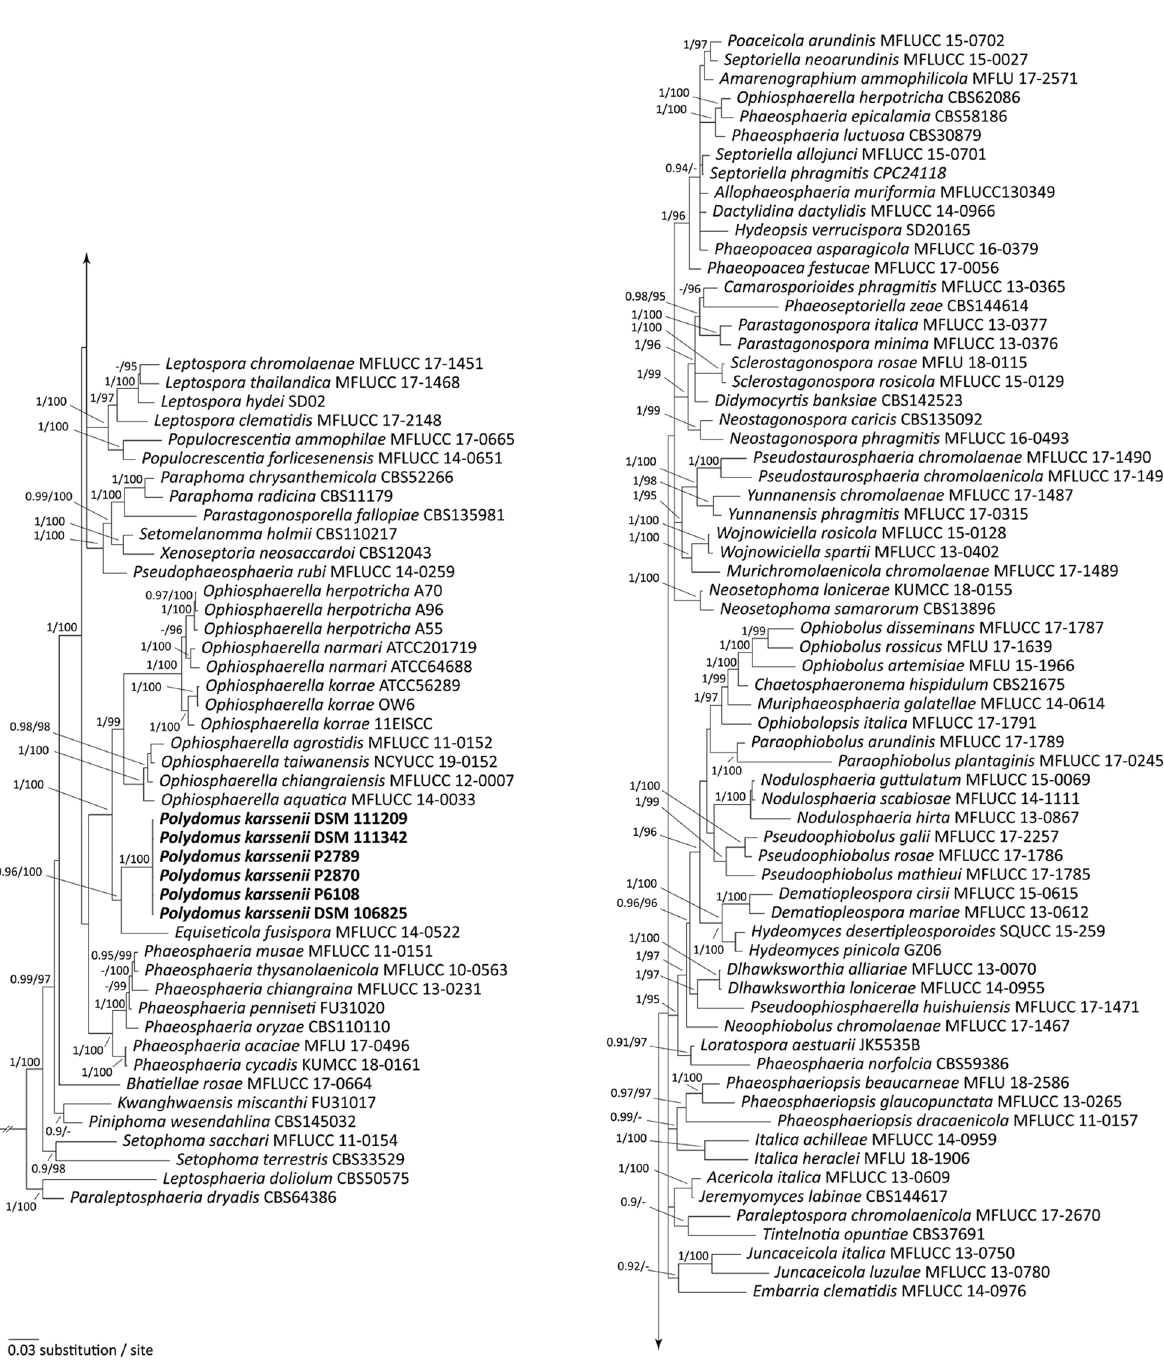
Fig. 3 Bayesian inference of the phylogenetic relationship of the fungus described here among Phaeosphaeriaceae based on ITS, LSU, SSU, and tefA partial sequences using GTRI I G as the nucleotide substitution model. Depicted is a 50% majority rule consensus tree derived from 7500 + + trees from the stationary phase of a Monte Carlo Markov Chain. The process was run for 5,000,000 generation and trees were sampled every 500 generations. Numbers at the nodes are estimates of a posteriori probability (BIpp, 0.9) and ultrafast bootstrap values (UFBT 95%) given ≥ ≥ as BIpp/UFBT. The new species is highlighted in bold. The topology was rooted with the distantly related species Leptosphaeria doliolum and Paraleptosphaeria